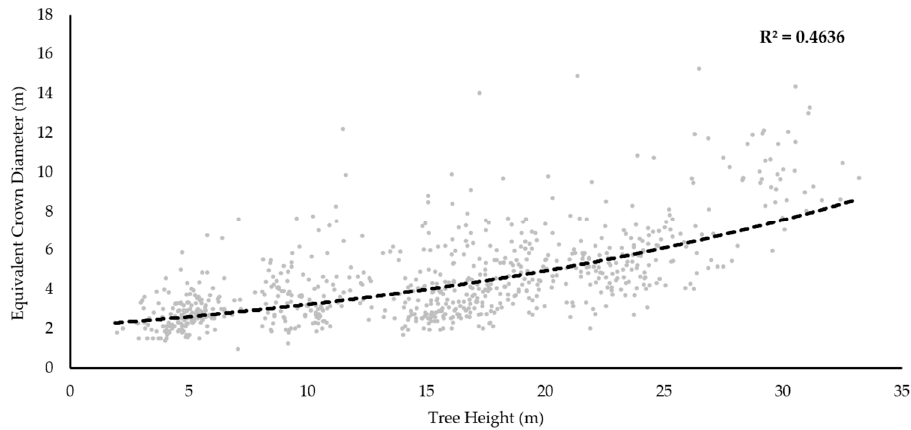
Figure 4. The relationship between equivalent crown diameter and tree height for all individuals across the eight sample plots. The dashed line is the exponential regression curve.